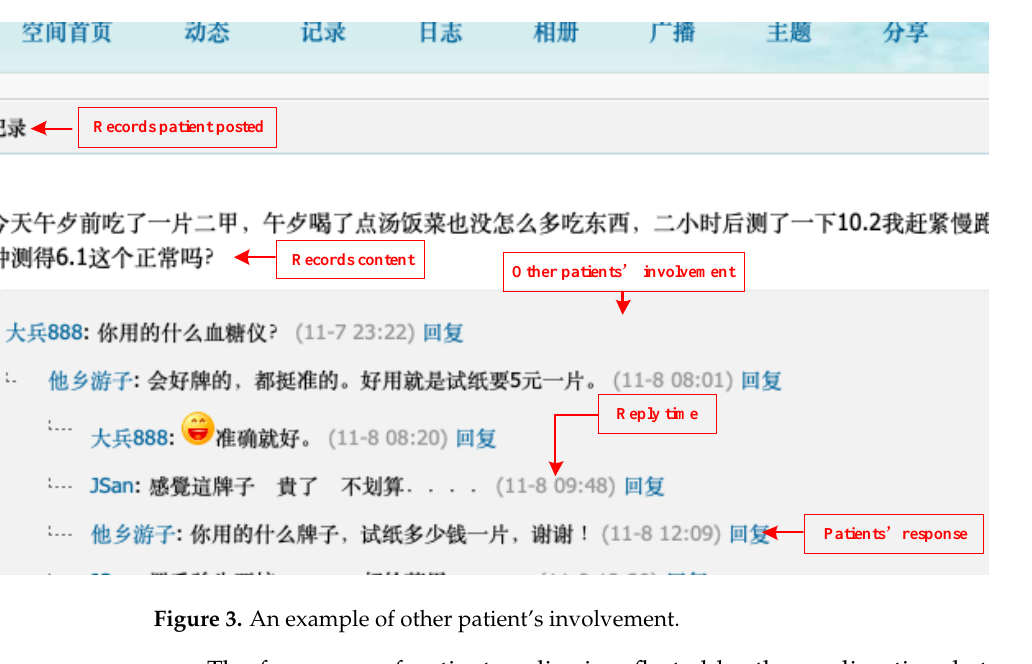
Figure 2. An example of the patient’s homepage.